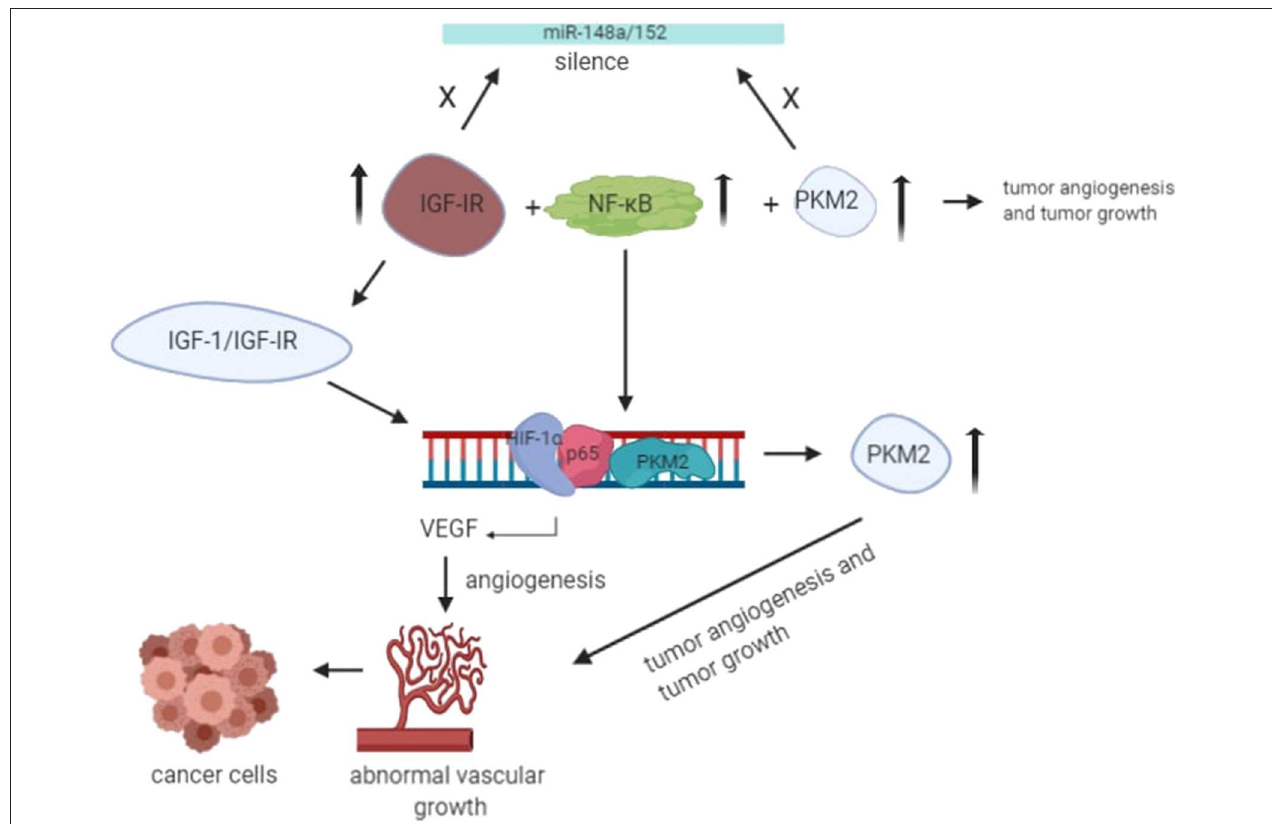
FIGURE 3 | Under the hypoxic condition, translocation of PKM2 and p65 to the nucleus takes place. Upon interaction with PKM2, NF- k B subunit p65 activates the transcription of HIF-1 α gene and its target gene, VEGF-A, in the nucleus. As a result, increased secretion of VEGF translates to increased blood vessel formation, contributing to tumor growth